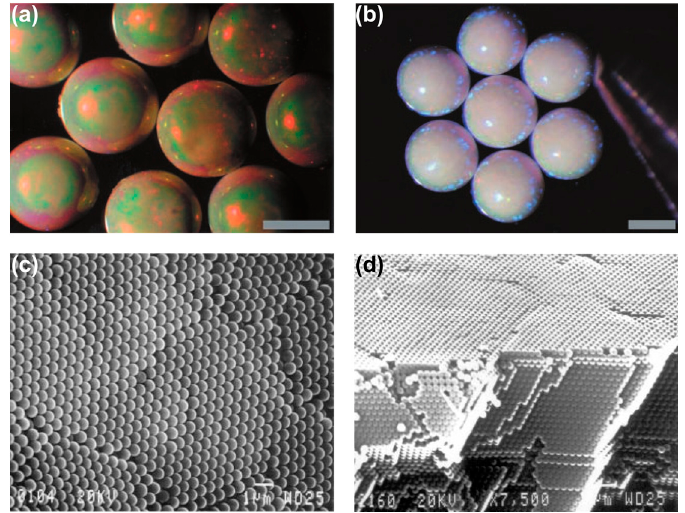
Figure 7. Typical examples for supraparticles prepared by drying of aqueous droplets containing polystyrene (PS) latex particles dispersed in fluorinated oil. Spherical supraparticles are formed showing different color patterns based on the size of the PS latex particles: ( a ) 270 nm and ( b ) 320 nm, scale bars = 500 µm. These patterns arise from light-diffraction due to long-range ordering of the particles as shown in ( c ) at the surface and ( d ) along the vertically-broken edge of a similar supraparticle; scale bars = 1 µm. Adapted with permission from [25] (p. 2241). Copyright 2000 Science.